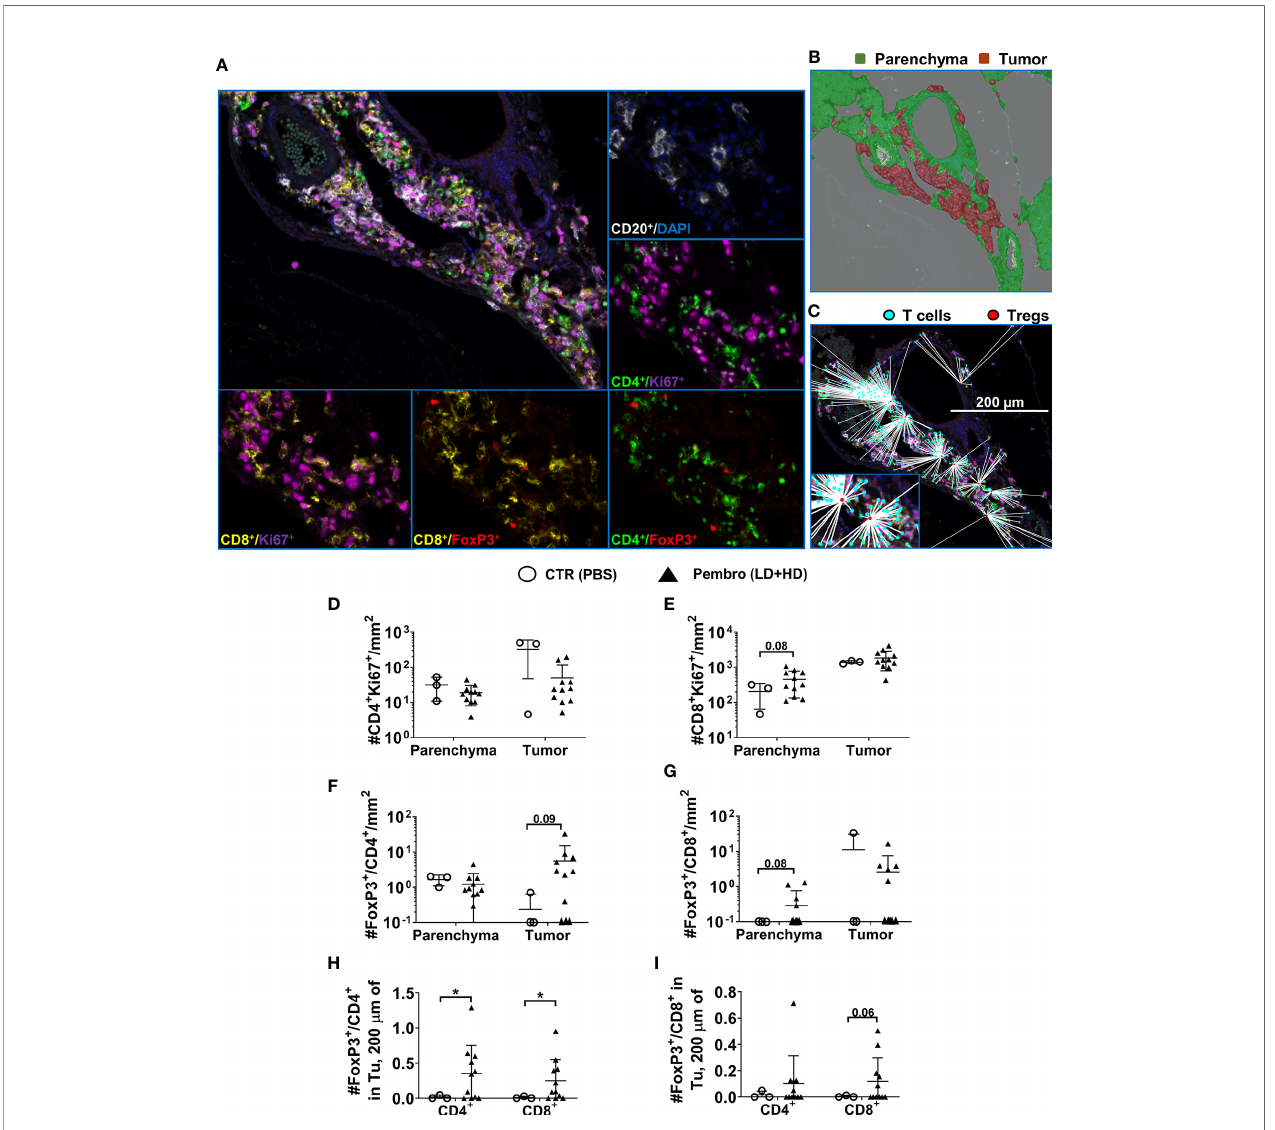
FIGURE 7 | Lower overall in fi ltration of CD4 + T cells but higher density and chance of intercellular interactions of regulatory T cells in tumors of mice infected with EBV/B95-8/fLuc and treated with pembrolizumab. (A) Representative example of a multiplexed immunohistochemical (mIHC) staining of liver tissue of a B95-8/fLuc- infected and pembrolizumab-treated humanized mouse followed by multispectral image (MSI) analysis/color deconvolution into six channels representing CD20 + (white), Ki67 + (magenta), CD4 + (green), CD8 + (yellow), FoxP3 + (red), and DAPI (blue) markers. (B) Tissue segmentation between the perivascular tumor mass (red) andthe non-neoplasticparenchyma (green). Expectedly,the tumor area corresponds with high density of proliferating CD20 + blast-likecells (A,B) . (C) Comprehensive distance mappingbetween FoxP3 + (reddots) andFoxP3 - T-cells(cyan dots). (D) The tumorareas of treated animals(black triangles, n = 11) showed fewer CD4 + T cells than controls(open circles, n = 3). (E) The parenchyma area ischaracterizedby a prominent population ofproliferating CD8 + cells, with a trend towardshigher densities in treatedanimals (not signi fi cant). (F) Densities of proliferating Ki67 + CD4 + Treg cellsinthe parenchyma orin thetumortissue, with an increase of tumor-in fi ltrating FoxP3 + /CD4 + Treg cells in the pembrolizumab-treated group (not signi fi cant), (G) that was also observed for parenchyma FoxP3 + /CD8 + Treg cells (not signi fi cant). (H) Distance metrics between FoxP3 + /CD4 + Tregs or (I) FoxP3 + /CD8 + Tregs revealingsigni fi cantly increased average number of FoxP3 + /CD4 + within a radiusof200 µm around anysingle CD4 + orCD8 + T cells residing in thetumorarea for pembrolizumab-treated (black triangles) micecompared with control (open circles) mice. Unpaired t test with Welch ’ s correction was applied to calculatestatistical signi fi cance. Standarddeviation isindicated. *P < 0.05